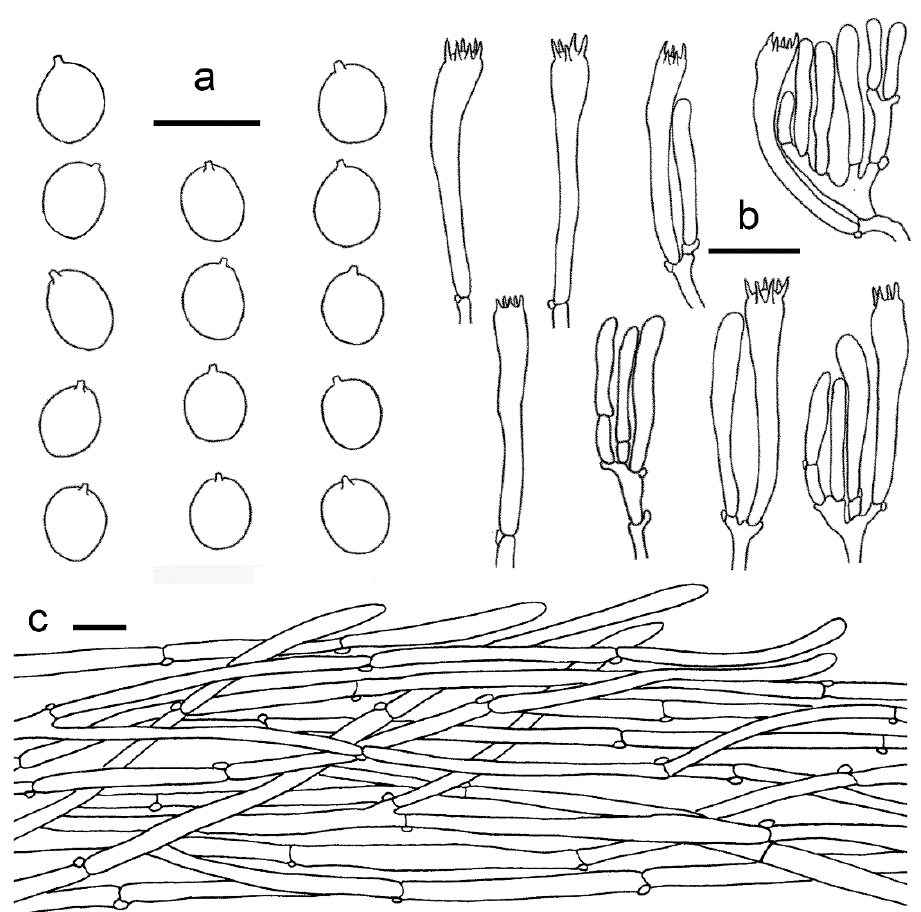
Figure 9. Cantharellus luteolus (GDGM60393, Holotype!). ( a ) Basidiospores. ( b ) Basidia, basidiola and elements of the subhymenium. ( c ) Pileipellis. Bars: ( a ) = 10 μ m; ( b , c ) = 20 μ